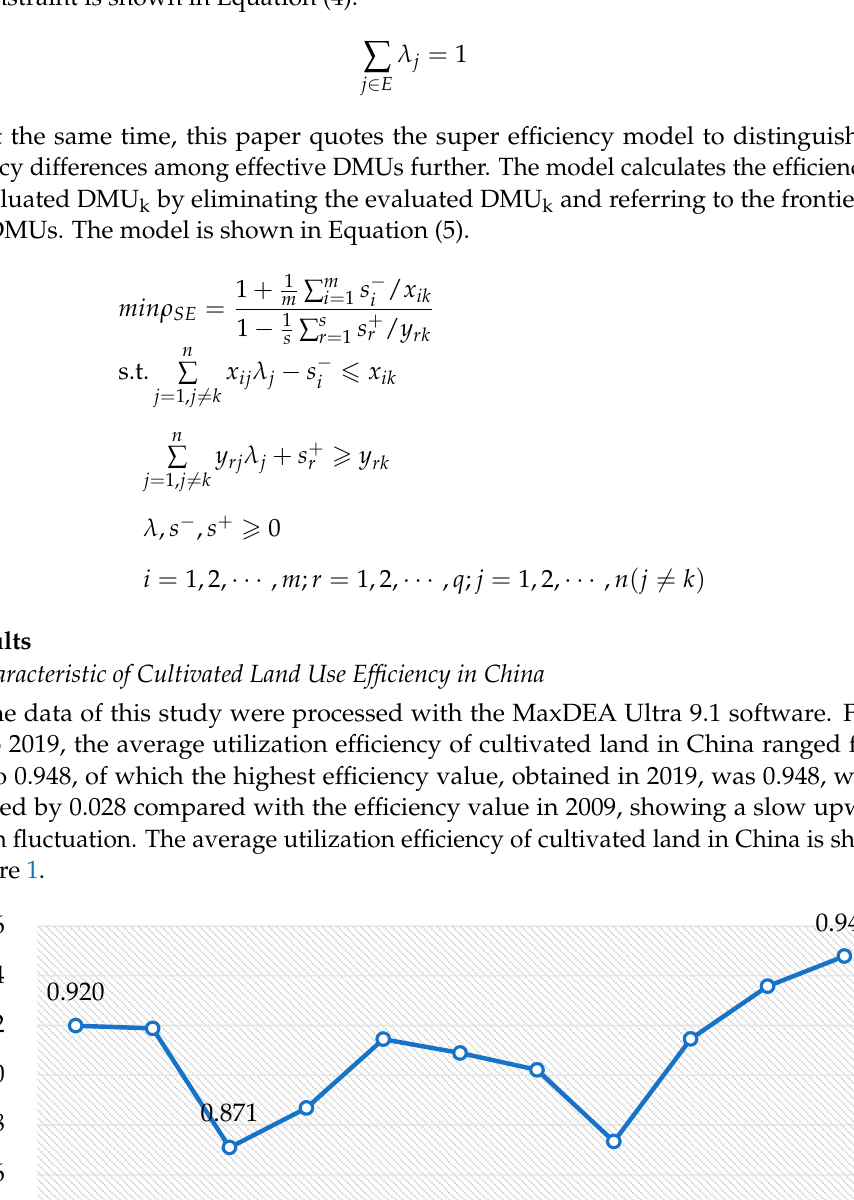
Figure 2. Cultivated land use efficiency in each province. 3.3. Improvement Potential of Cultivated Land Use Efficiency in China By using the super efficiency MinDS model, we can obtain the cultivated land use efficiency of China as a whole and in provincial regions, as well as the degree of improve- ment when the cultivated land use efficiency reaches effectiveness—in other words, the degree of reduction in input indicators and non-expected output indicators, and the de- gree to which the expected output indicators can be increased. From 2009 to 2019, China’s three items with the highest average relaxation improvement ratio in terms of cultivated land use efficiency were carbon emissions, pesticides and agricultural machinery. They all had improvement rates of over 10%. Furthermore, among the input indexes, the pro- portion of irrigation input that can be reduced is the lowest. When the output value is practical as a positive output, the improvement ratio is small, which is 3.76%. The details can be seen in Table 3.